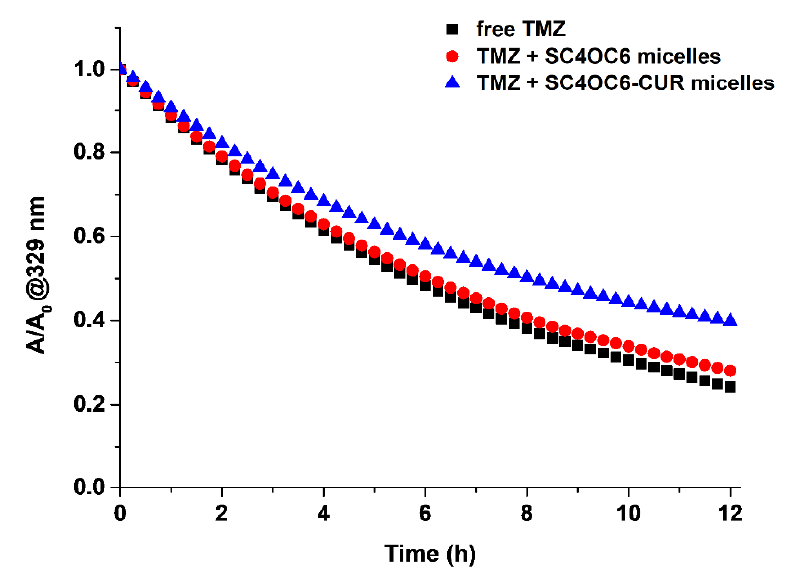
Figure 10. Absorbance values recorded at 330 nm for free TMZ (0.11 mM) (black squares), TMZ (0.11 mM) in SC4OC6 (0.22 mM) complex (red circles) and in SC4OC6/CUR/TMZ nanoassembly (0.22 mM/0.014 mM/0.22 mM) (blue triangles) in neutral aqueous solution at 37 °C over time.